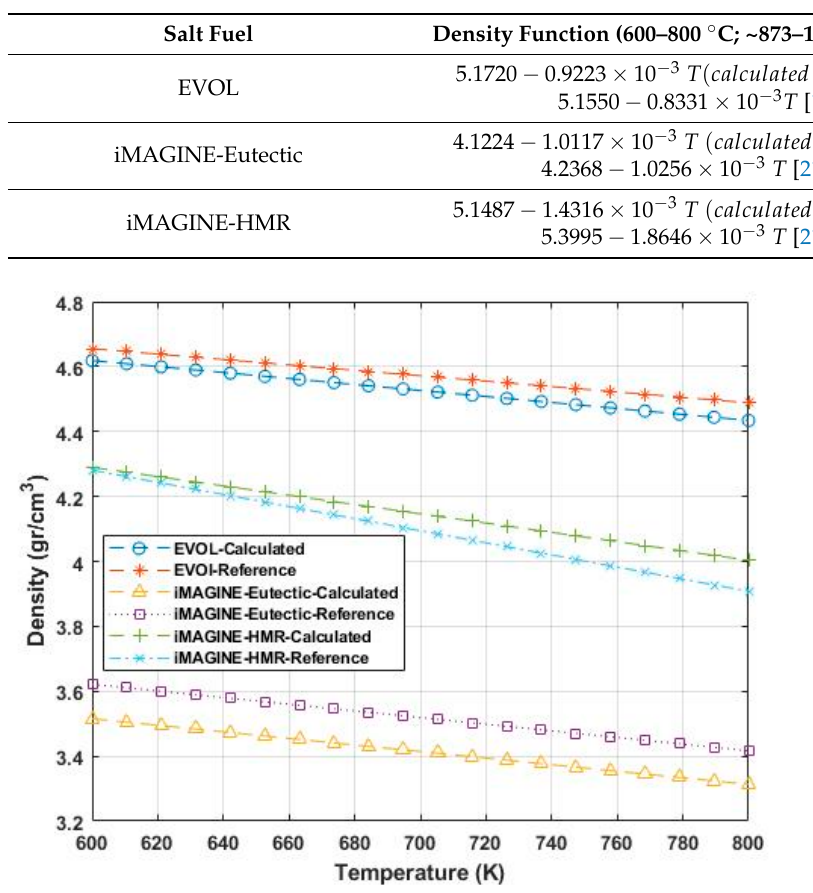
Figure 5. Density functionality of temperature for EVOL and iMAGINE salt fuel systems.